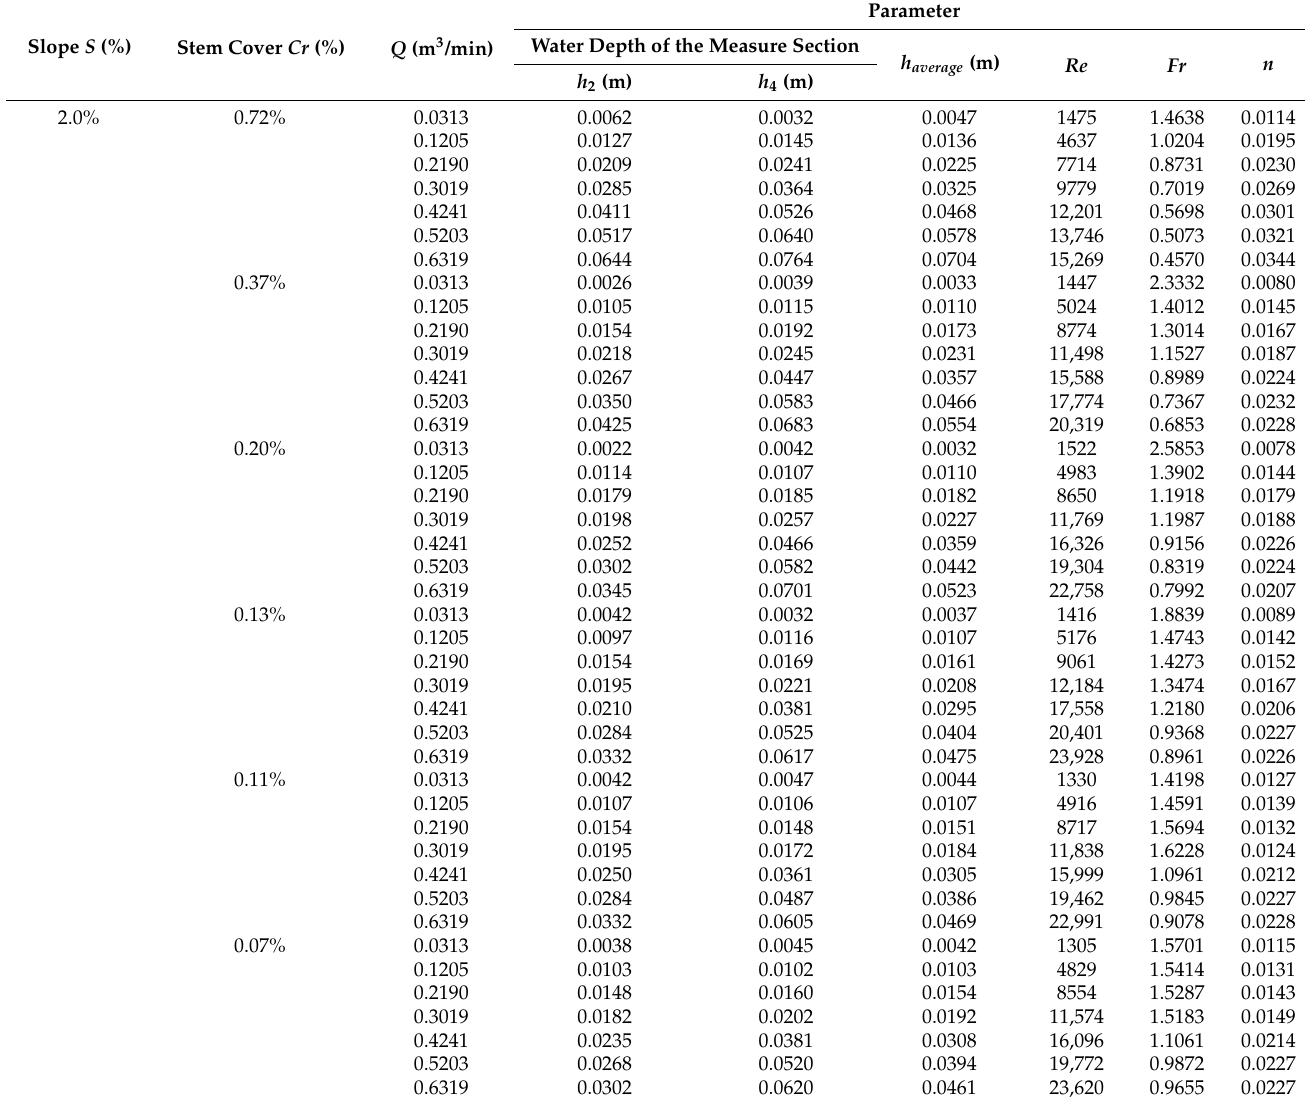
Table 3. Experimental data of hydraulic parameters of six different vegetation stem cover under the condition of S = 2.0% ( Cr is 0.72%, 0.37%, 0.20%, 0.13%, 0.11% and 0.07%, respectively).